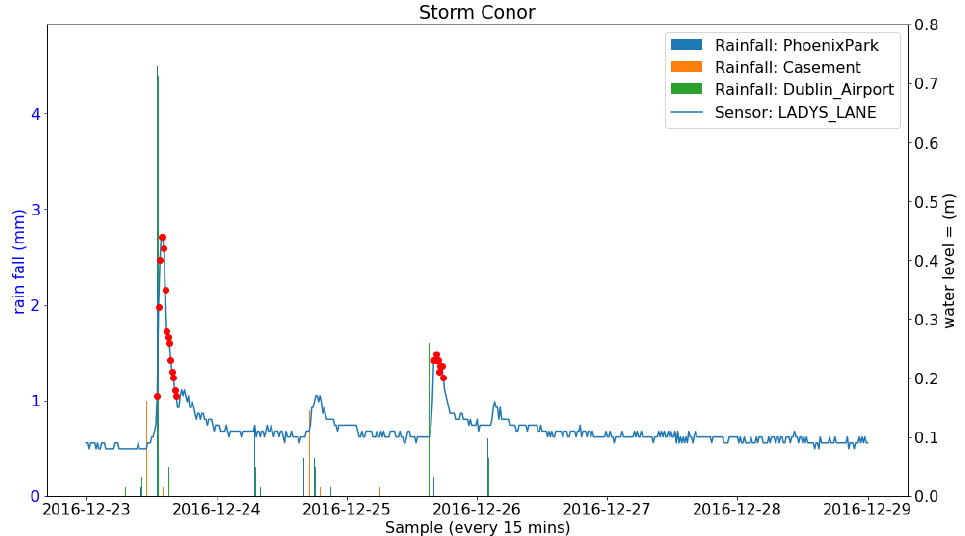
Figure 14. Rainfall from three Met Éireann weather stations and the water level sensor measurements along with the anomalies detected and the two events constructed during the Storm